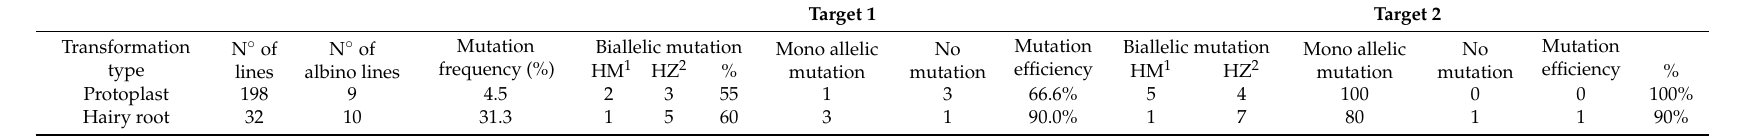
Table 1. Mutation analysis in the CiPDS gene. Analysis were performed on plants regenerated from protoplasts or hairy